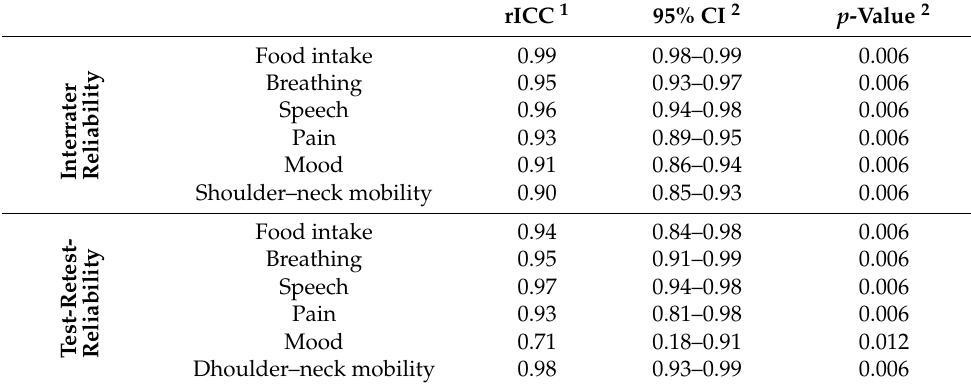
Table 4. Reliability of the adapted HNC-FIT